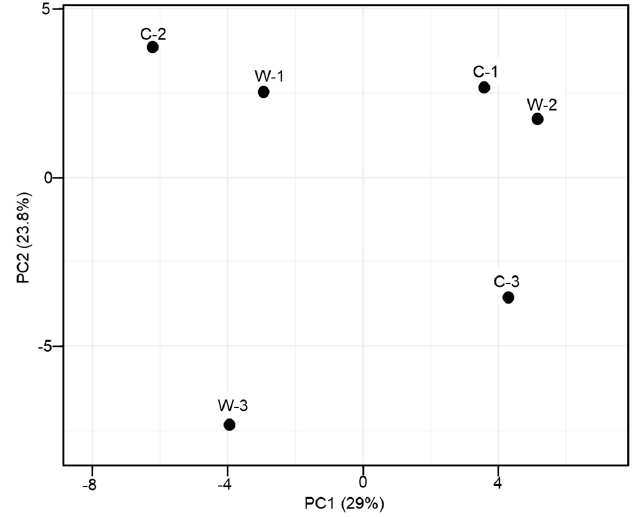
Figure 6. Comparison of PCA results at the generic level among the gut microbes of shrimp in control (C), and W5 (W) groups.